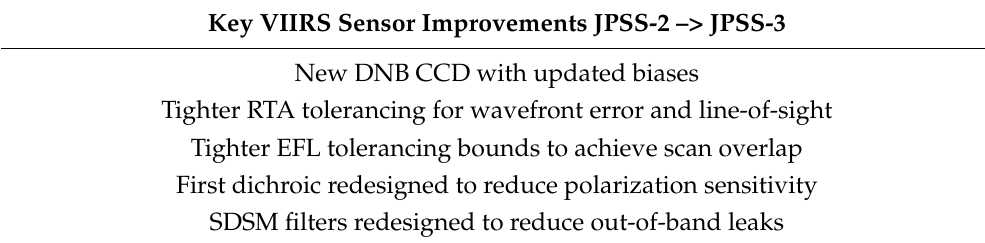
Table 2. Key JPSS-3 VIIRS design changes implemented based on lessons learned from